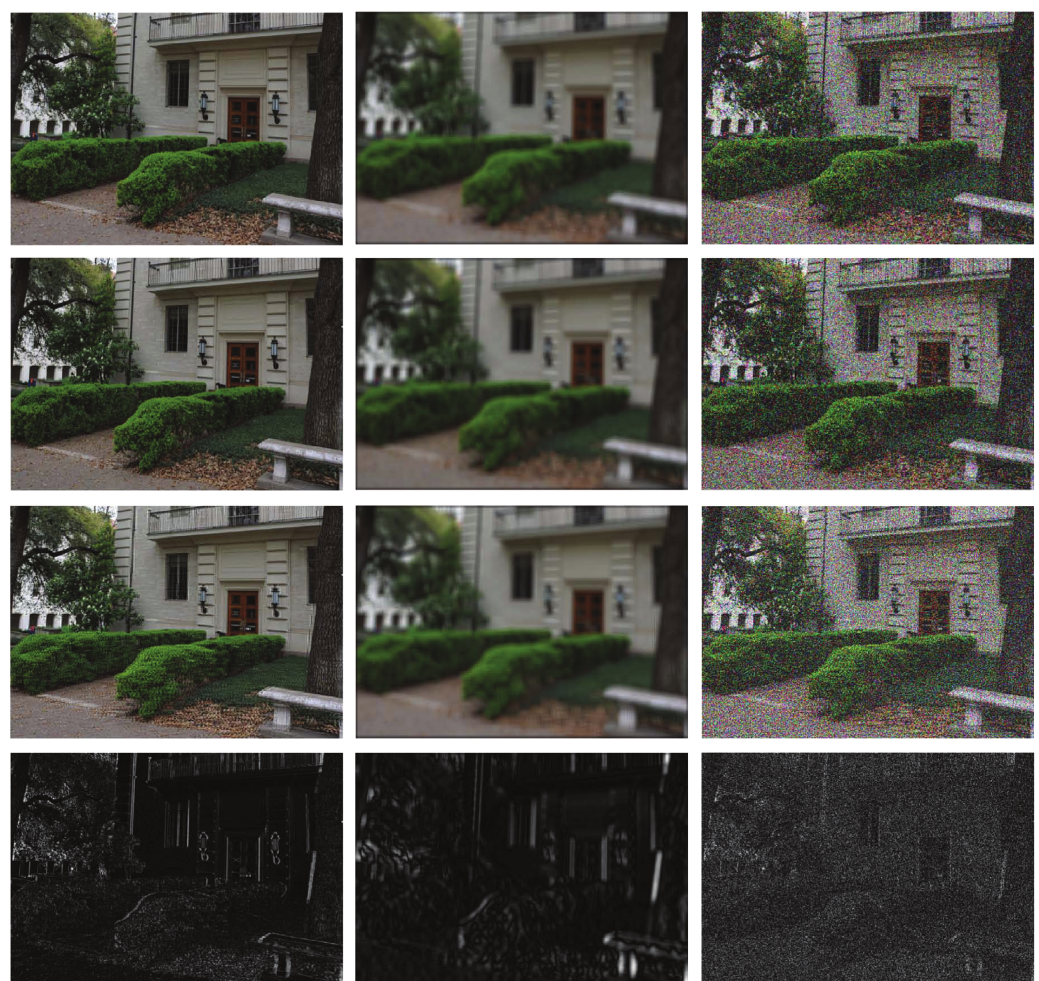
Figure 3: Examples of distorted stereoscopic images with different distortion types and the corresponding fusion and difference maps: the original stereoscopic image (left), distorted stereoscopic image with Gaussian blur (middle), and distorted stereoscopic image with white Gaussian noise (right). The first to the last rows show the left-view images, right-view images, fusion maps, and difference maps,